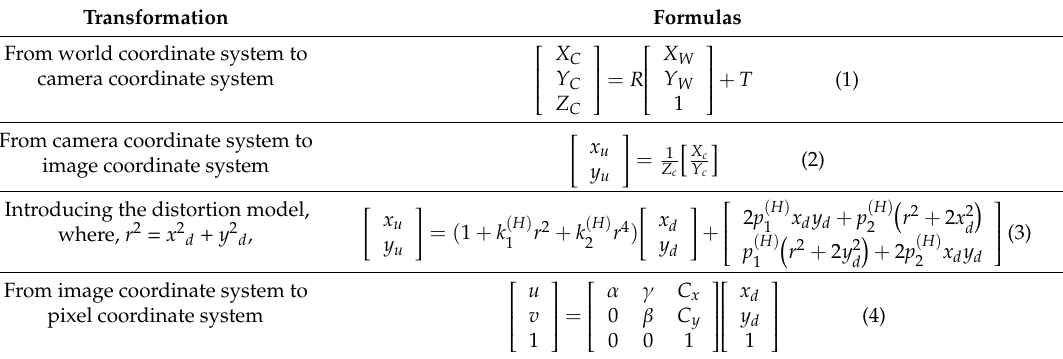
Table A1. Coordinate transformation camera model.